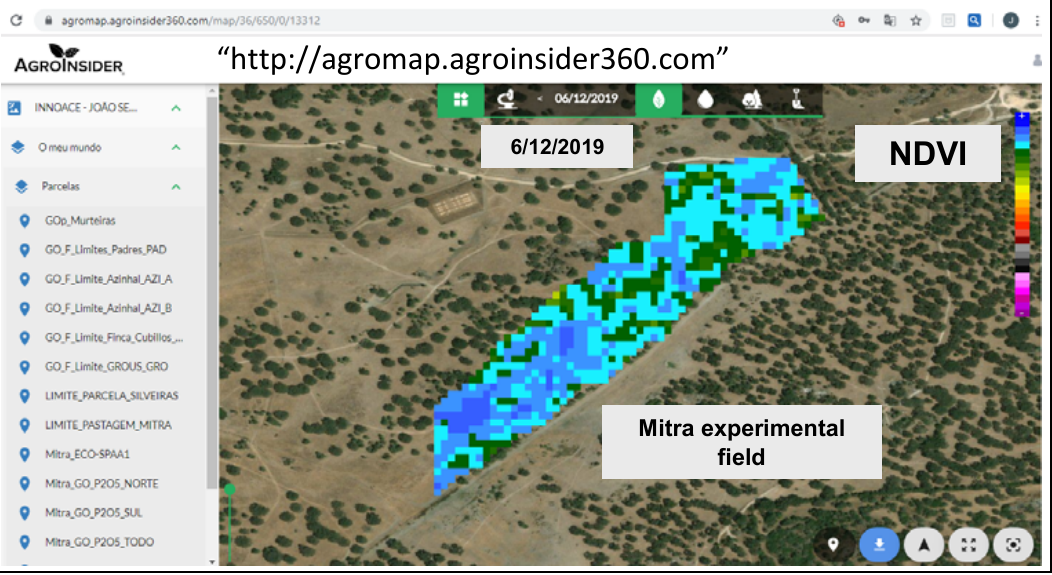
Figure 12. Interface of AgroInsider electronic platform which provides agricultural consultancy services in southern Portugal.